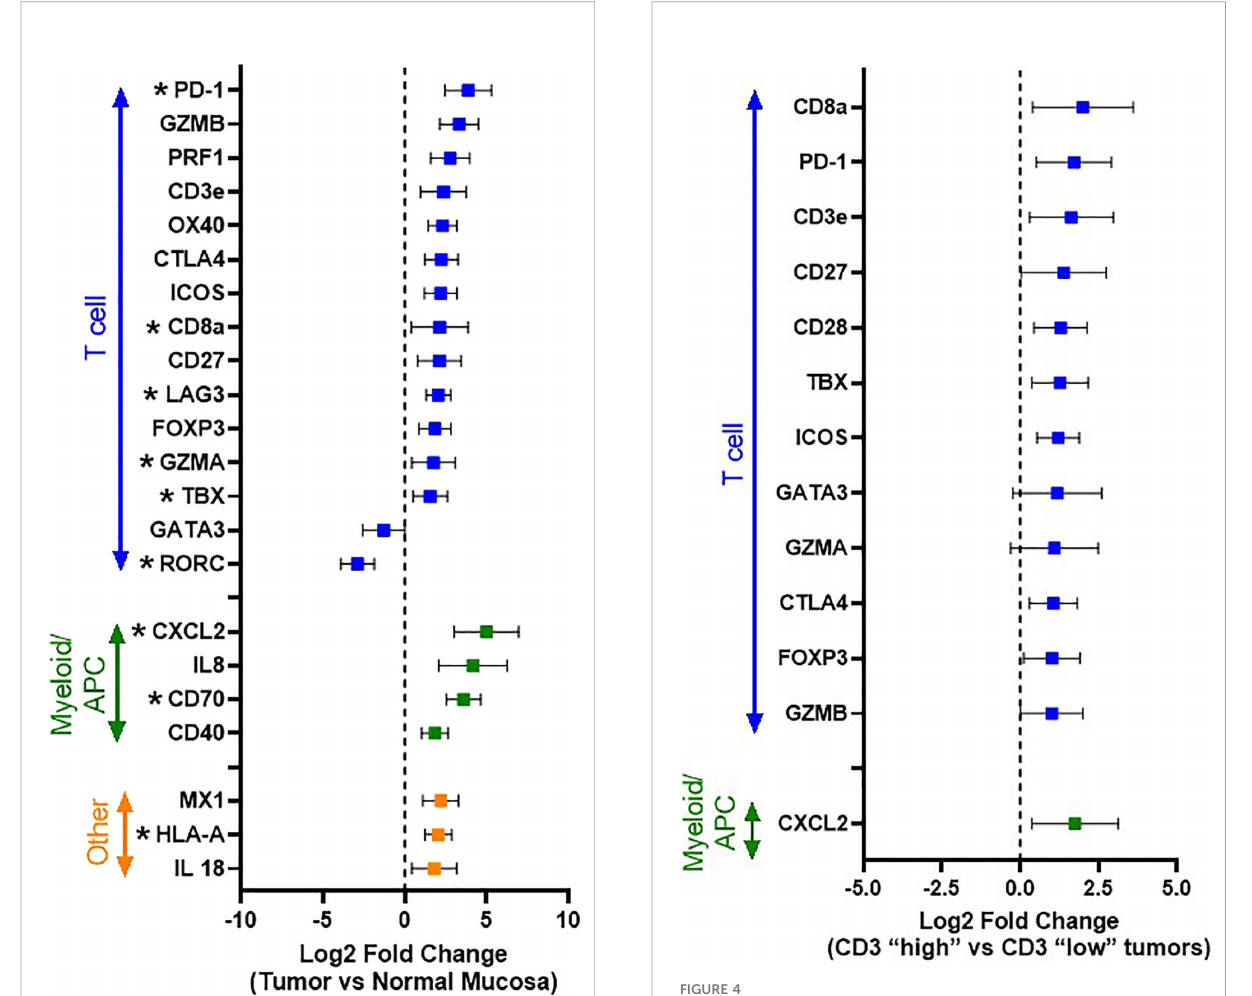
FIGURE 4 Differential immune gene expression between immunologically “ hot ” vs. “ cold ” canine OSCC. Log2 fold change forest plots of differentially expressed genes with an FDR q value <0.05 between CD3 “ high ” (n=17) vs CD3 “ low tumors ” (n=17). Tumors were strati fi ed into CD3 “ high ” vs “ low ” groups based on median dichotimization of IHC density. Genes are grouped according to immune cell type/function. Data represent mean +/-